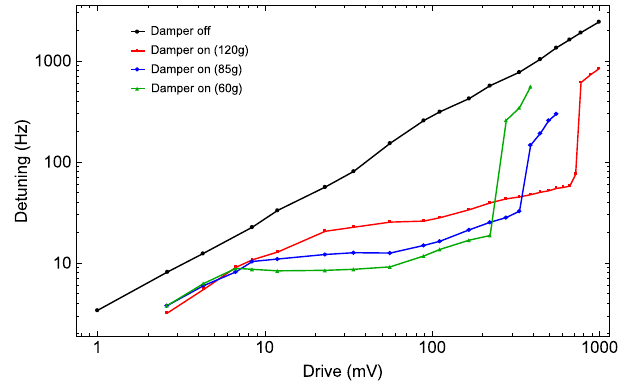
FIG. 11. Responses (represented by detuning) of drive sweep- ing with the damper off and with 120, 85, and 60 g dampers on.